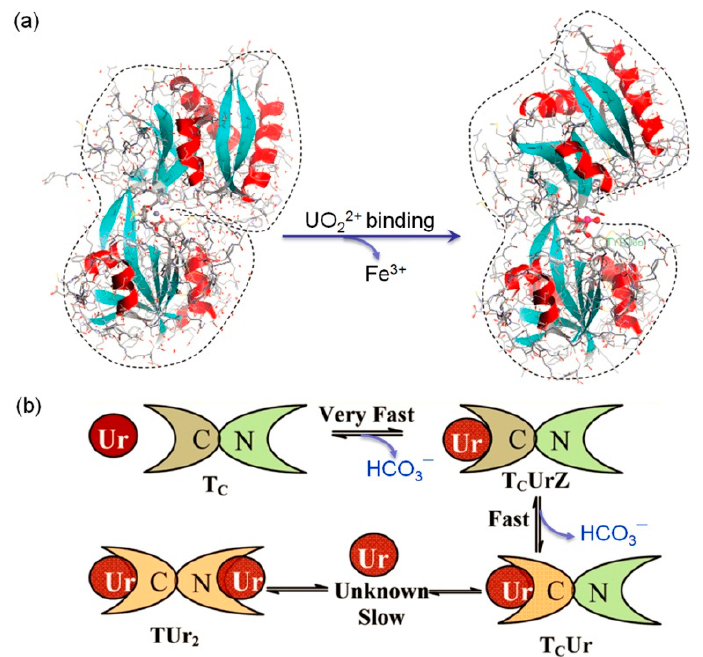
Figure 5. ( a ) An X-ray crystal structure of the N-lobe of holotransferrin (PDB code 1A8E) (left) and the proposed conformational changes upon uranyl binding to the Fe 3 + site (right). Reprinted with permission from Ref. [61], Copyright 2007 American Chemical Society. ( b ) A schematic presentation of uranyl binding to Tf in several steps with di ff erent rates. Reprinted with permission from Ref. [79] with slight modification, Copyright 2011 American Chemical